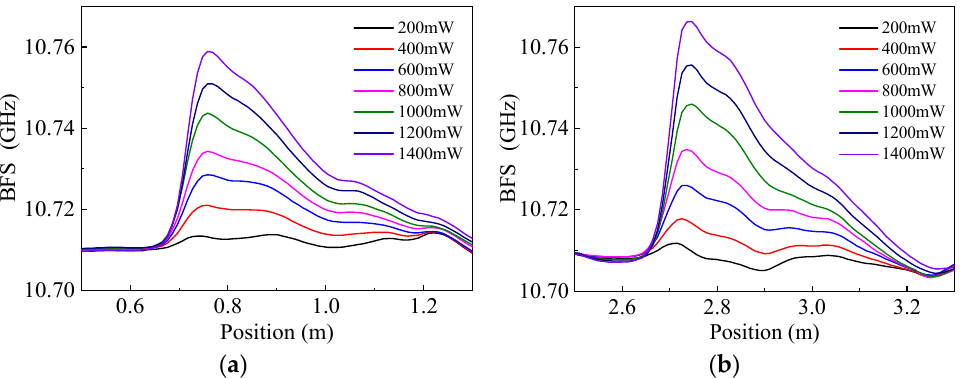
Figure 6. BFS distributions of the two heated sections of the sensing fiber at different input optical powers of the HAFs: ( a ) Section 1; ( b ) Section 2. powers of the HAFs: ( a ) Section 1; ( b ) Section 2.